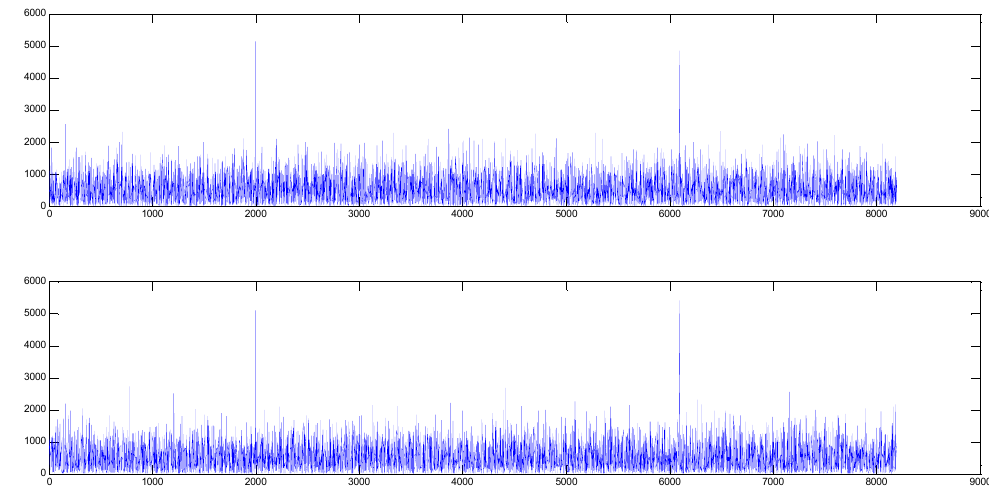
Figure 3. Correlation peaks on condition that SNR equals − 10 dB, N = 4096 F = 8 and k = 200.